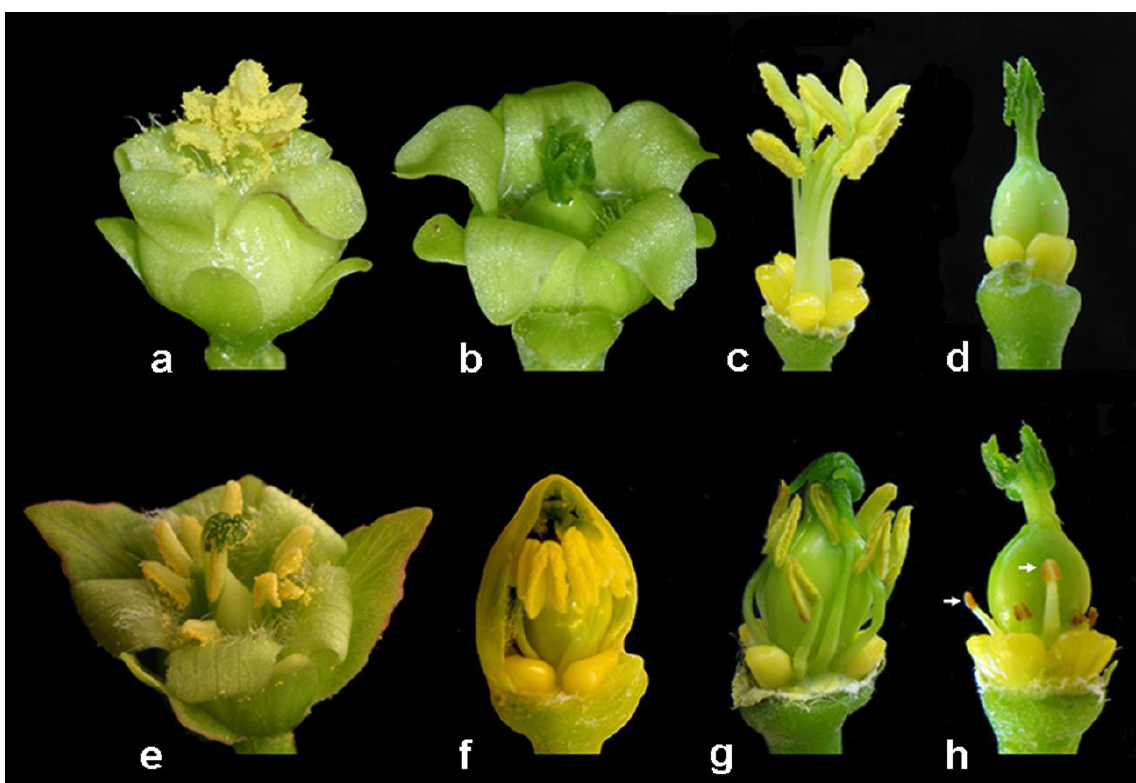
F IGURE 1. Jatropha curcas flower types: Regular staminate (a) and pistillate (b) flowers and the same flowers with the sepals and petals removed (c and d, respectively). Early-blooming perfect flower, when fully open (e), at the mature bud stage (f) and with the sepals and petals removed (g). Early blooming pistillate flower with the sepals and petals removed (h). Arrows point at vestigial